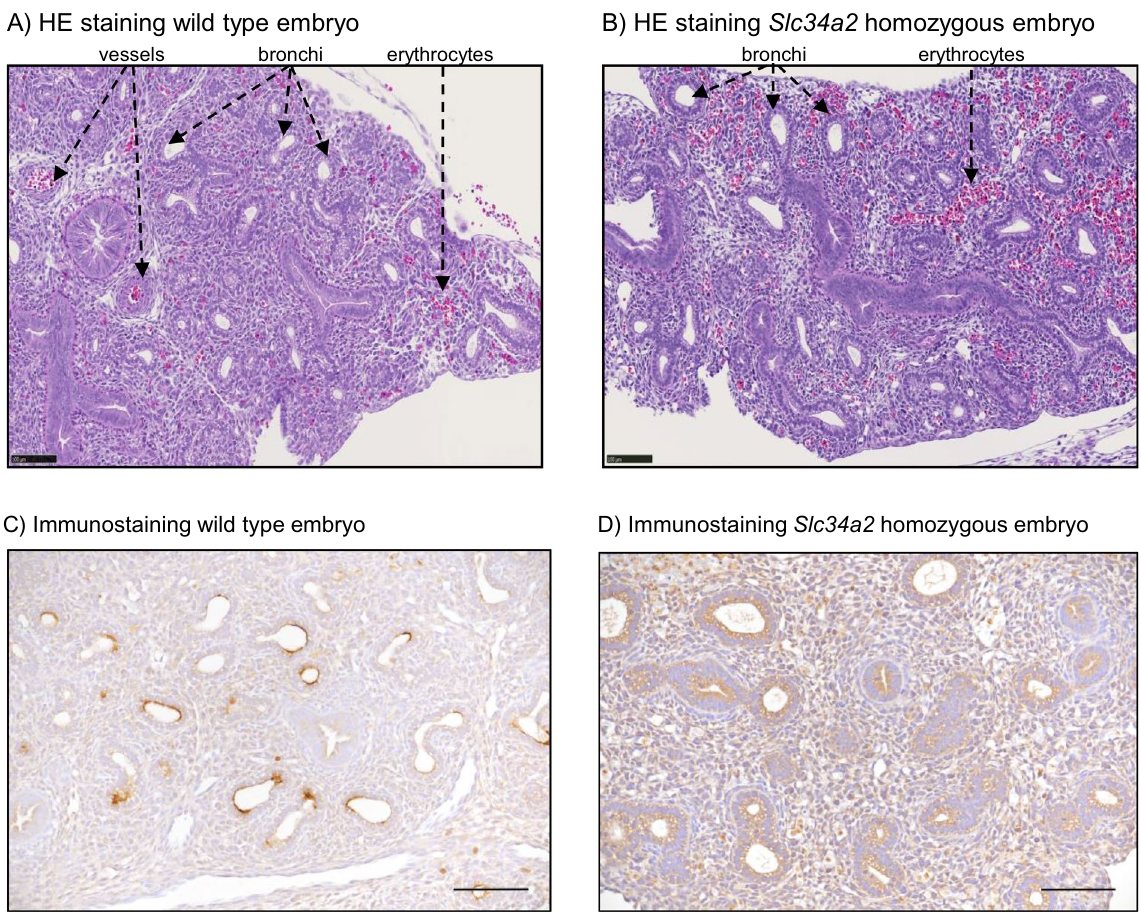
Figure 7. Lungs from ( A , C ) wild type and ( B , D ) Slc34a2 homozygous E18 embryos stained with ( A , B ) H&E or with ( C , D ) a NaPi-IIb antibody. Scale bars: 100 µm in ( A , B ); 50 µm in ( C , D